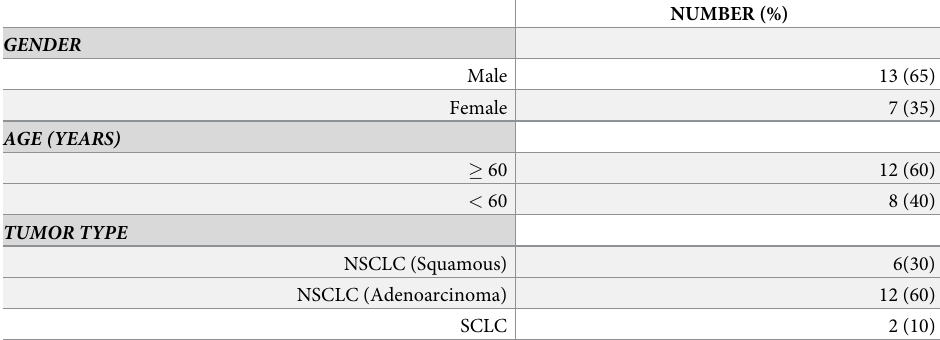
Table 1. Patient characteristics in this trial